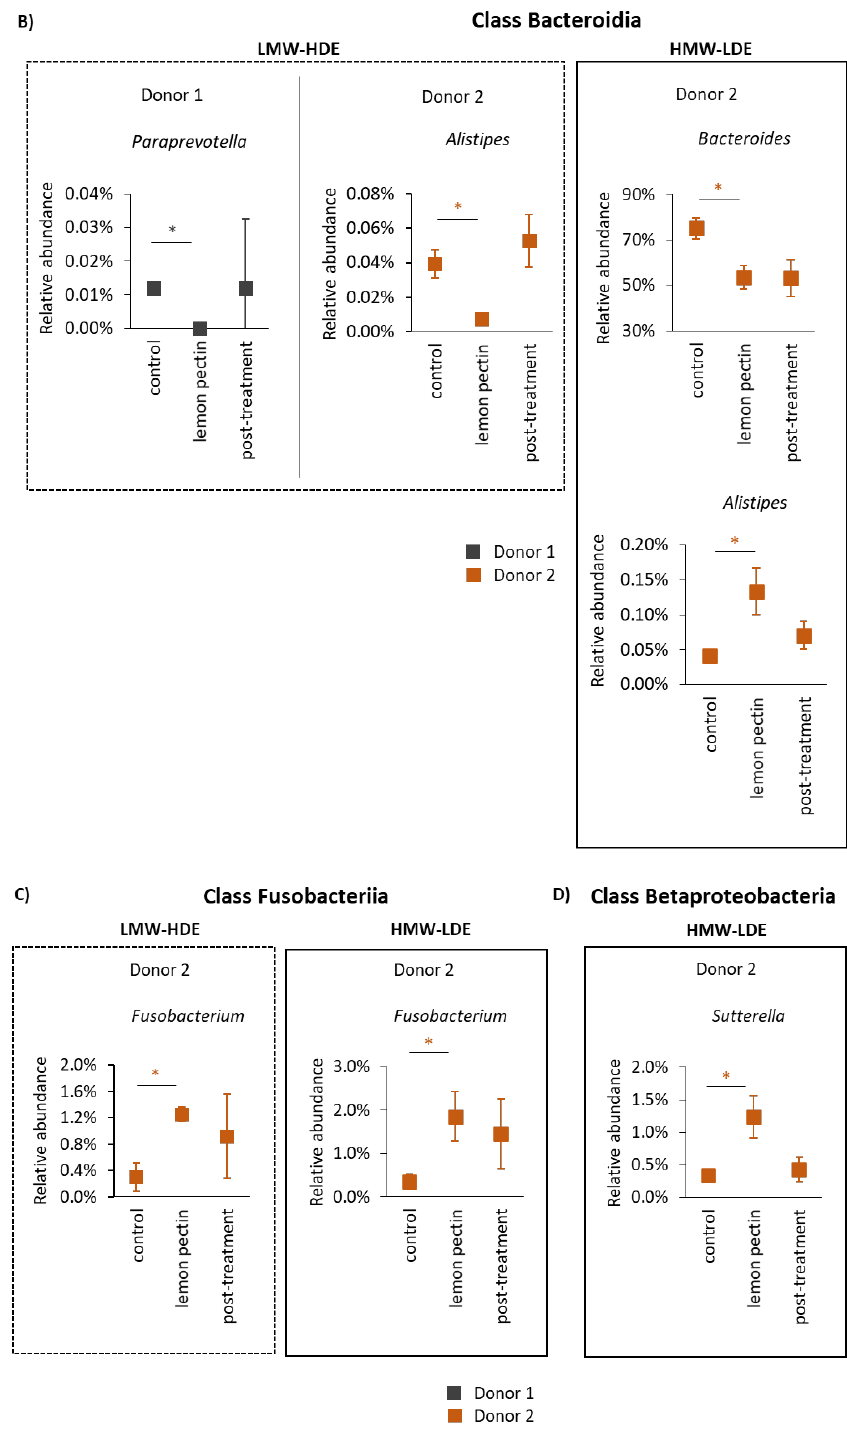
Figure 4. Genus-level taxa significantly altered by LMW-HDE and HMW-LDE lemon pectin. Statistically significant changes are indicated in the figure with an asterick (*) symbol. Taxa from both donors, effected by either the LMW-HDE or the HMW-LDE lemon pectin are grouped according to class. ( A ) Clostridia; ( B ) Bacteroidia; ( C ) Fusobacteriia; ( D ) Betaproteobacteria.